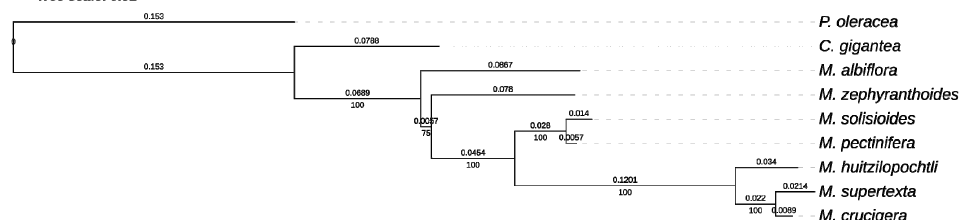
Figure 5. Phylogenetic ML tree for the seven studied Mammillaria species based on 14 loci of high molecular variation (marked with an asterisk in Table 3), with Portulaca oleracea and Carnegiea gigantea used as outgroups. The branch length is shown above the branches, whereas bootstrap values are displayed below the branches.